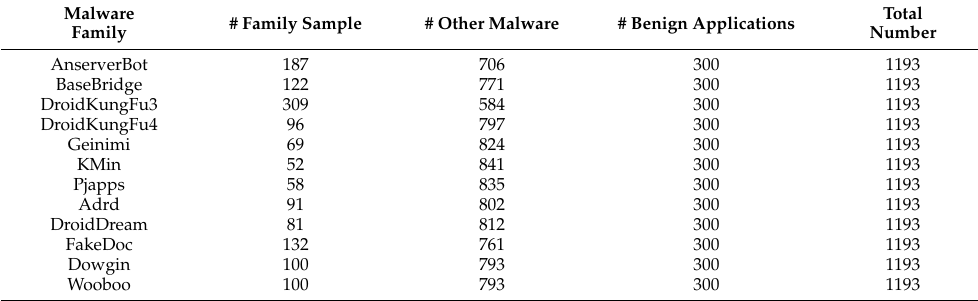
Table 3. The proportion of malicious and benign samples in each experiment.